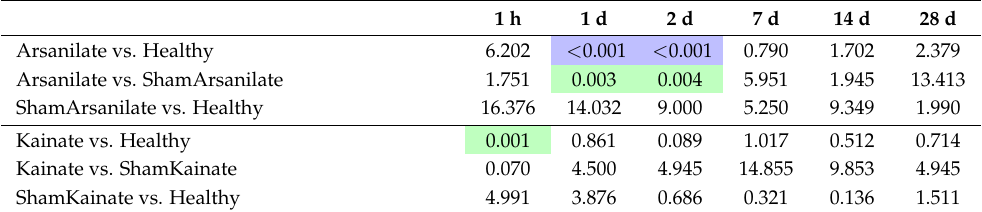
Table A1. Bonferroni-corrected p values for fraction of the time spent immobile (one-sided Mann– Whitney U test; p values lower than 0.05, 0.01 and 0.001 are highlighted in yellow, green and blue, respectively).